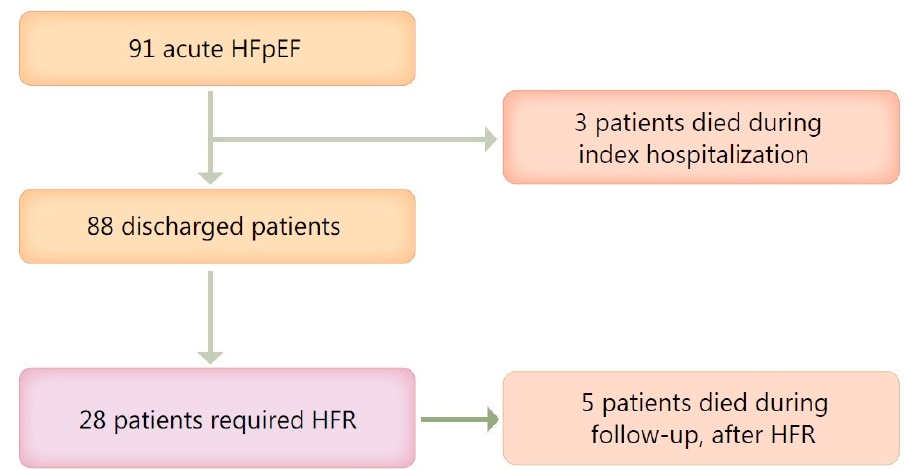
Figure 1. Patient population flow-chart. HFpEF- heart failure with preserved ejection fraction; HFR- heart failure readmissions